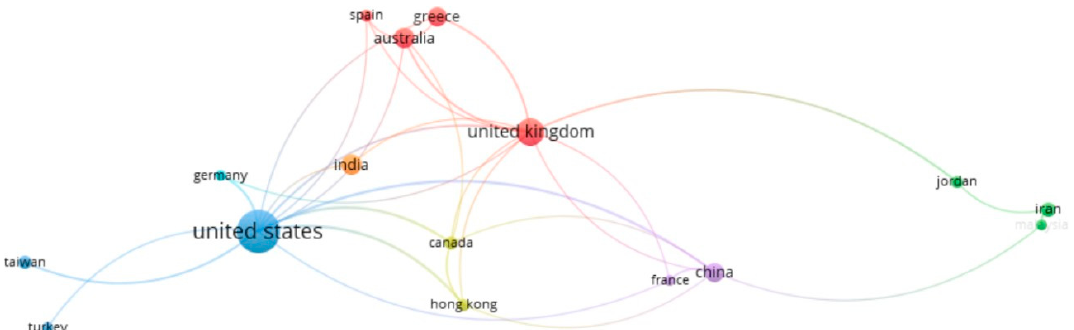
Figure 3. Co-authorship among countries.